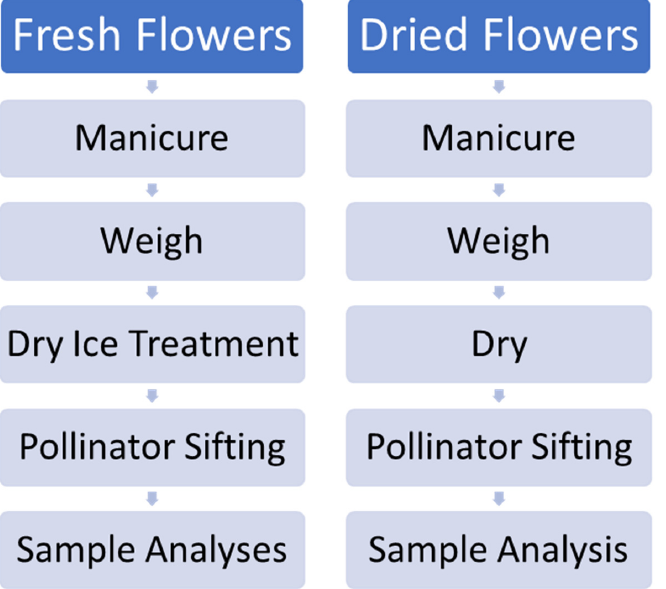
Figure 12. Schematic of procedures employed for experimental fresh and dried flower